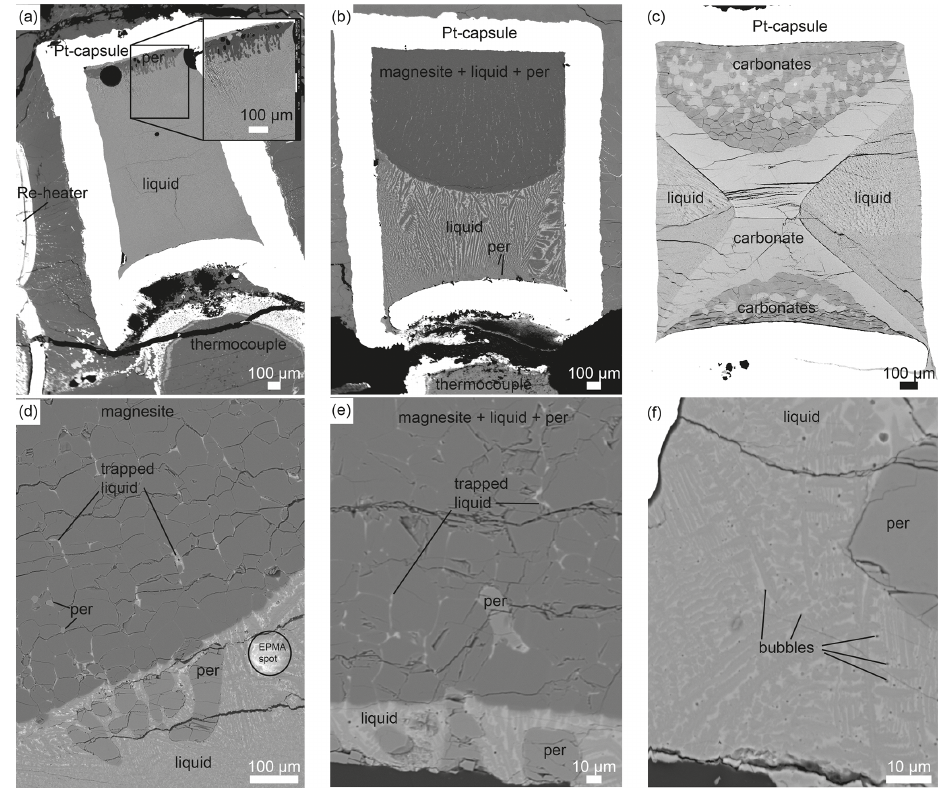
Figure 2. BSE images of run products: (a) run 115; (b) run 116; (c) run 121; (d) run 109; (e, f) run 110. Abbreviation: per, periclase.